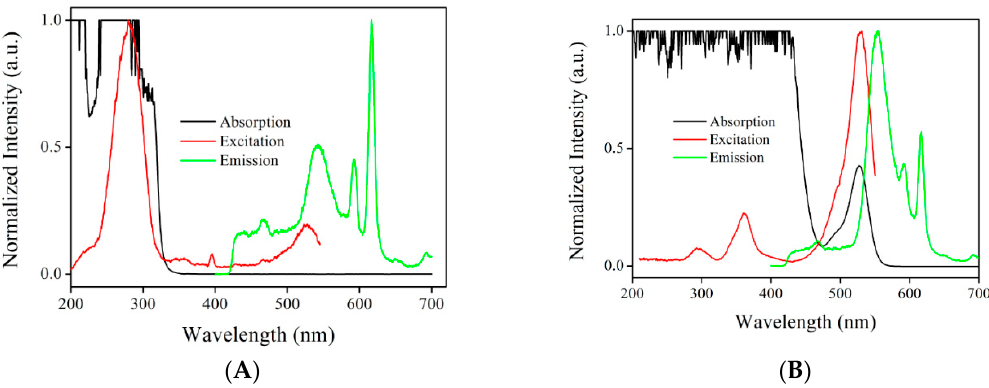
Figure 5. ( A ) Photophysical spectra of RS6h@EuBTC in ethanol (0.1 mg/mL); ( B ) Photophysical spectra